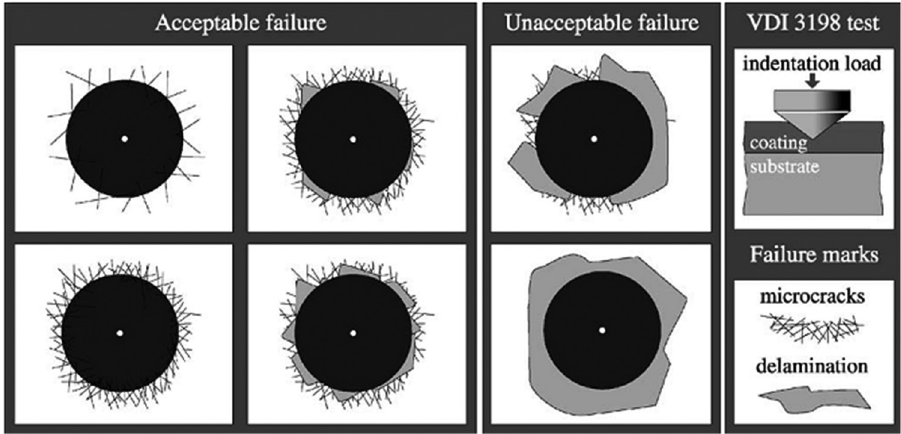
Figure 2: Reference standard for adhesion strength in Rockwell hardness test [ 14 ] .